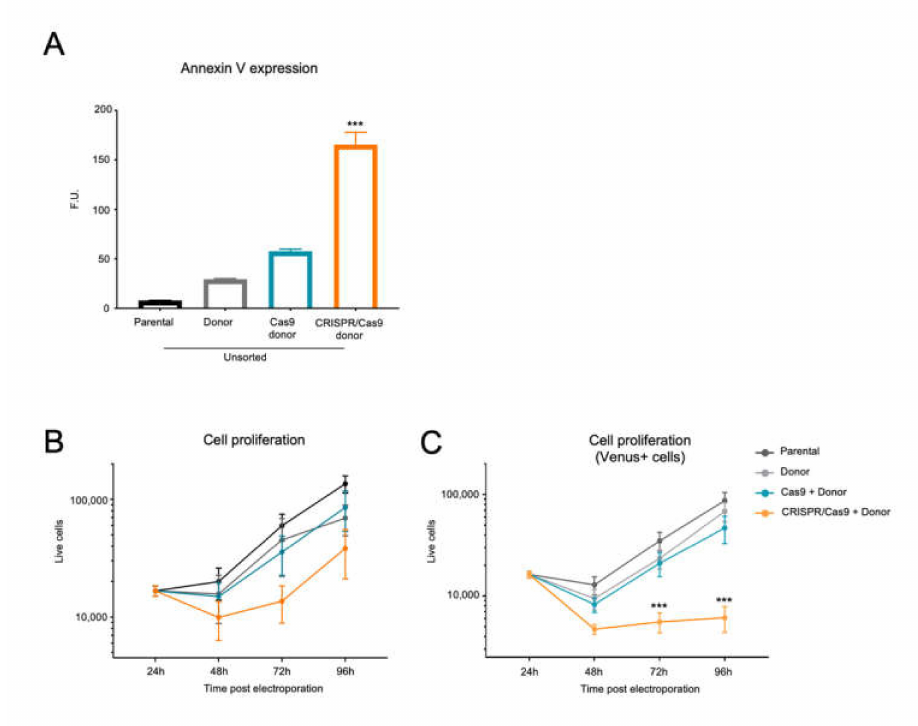
Figure 5. Functional analysis of CRISPR-Trapped BCR/ABL . ( A ) Annexin V expression analysis by flow cytometry of K562 cells 48 h after electroporation with the CRISPR-Trap system (CRISPR/Cas9 + Donor) and controls (Parental, Parental + Donor, Cas9 + donor). ( B ) Cell proliferation assay of K562 24 h after electroporation with CRISPR-Trap system and controls, and ( C ) Venus-positive sorted cells, over 96 h (mean ± SEM; ***, p <